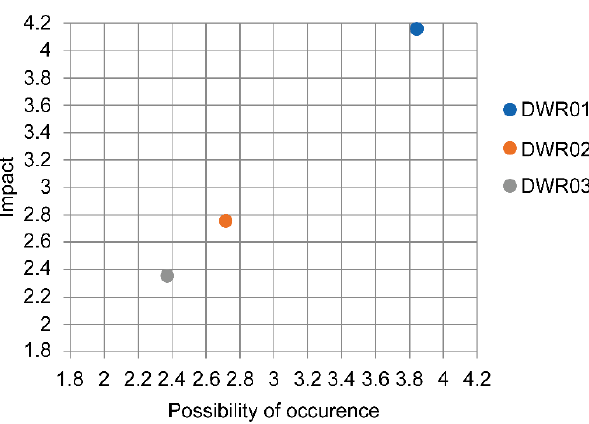
Figure 3. Risk to DWR (drinking water resources).